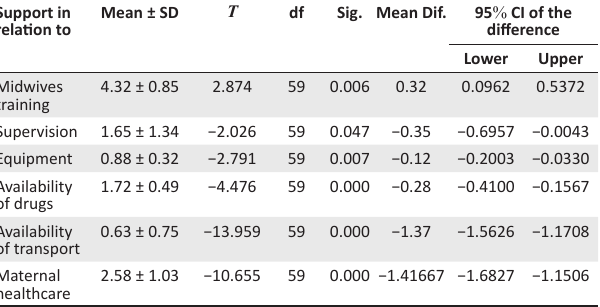
TABLE 3: One-sample test on measures of support from